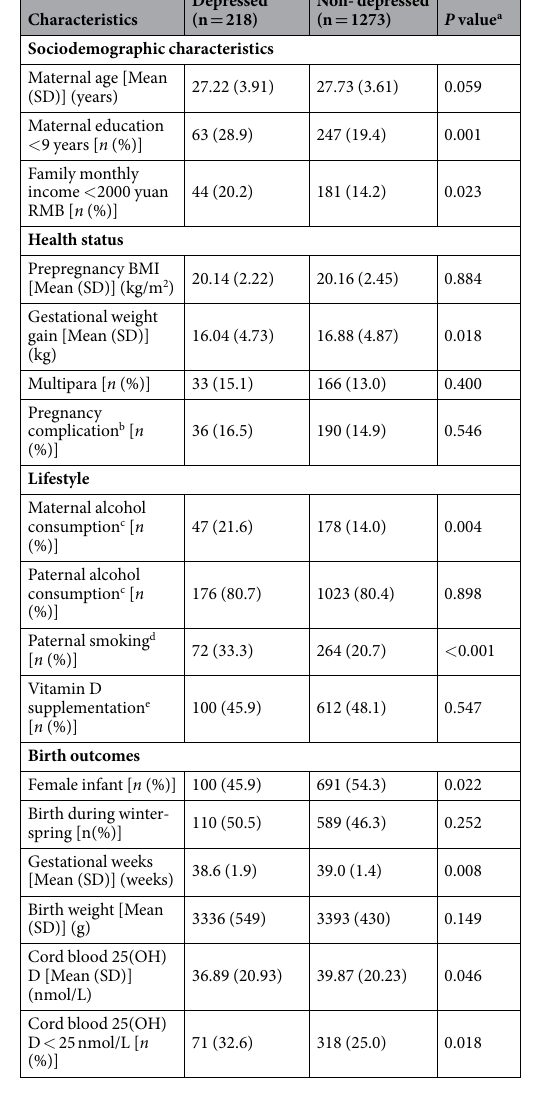
Table 1. Demographics and clinical characteristics between mother-infant pairs with and without maternal depression. Abbreviation: 25(OH)D, 25-hydroxyvitamin D; BMI, body mass index. a Chi-square test for categorical variables and Student’s t-test for continuous variables with univariate analysis. b Complication of pregnancy included diabetes mellitus, hypertension, abnormal heart function, thyroid disease, intrahepatic cholestasis of pregnancy, and moderate and severe anemia. c Maternal and paternal alcohol consumption was defined as any alcohol consumption up to 6 months before pregnancy. d Paternal smoking was defined as more than 6 cigarettes daily up to 6 months before pregnancy. e Maternal vitamin D supplementation was defined as the use of vitamin D supplement for greaterthan two months during